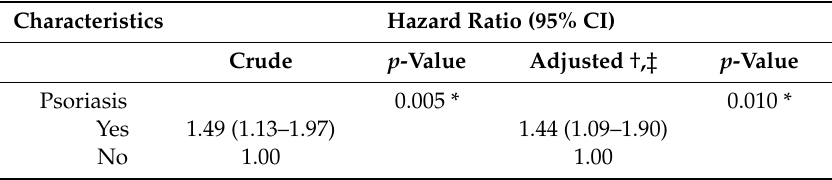
Table2. Crudeandadjustedhazardratios(95%confidenceinterval)ofpsoriasisforsuddensensorineural hearing loss.